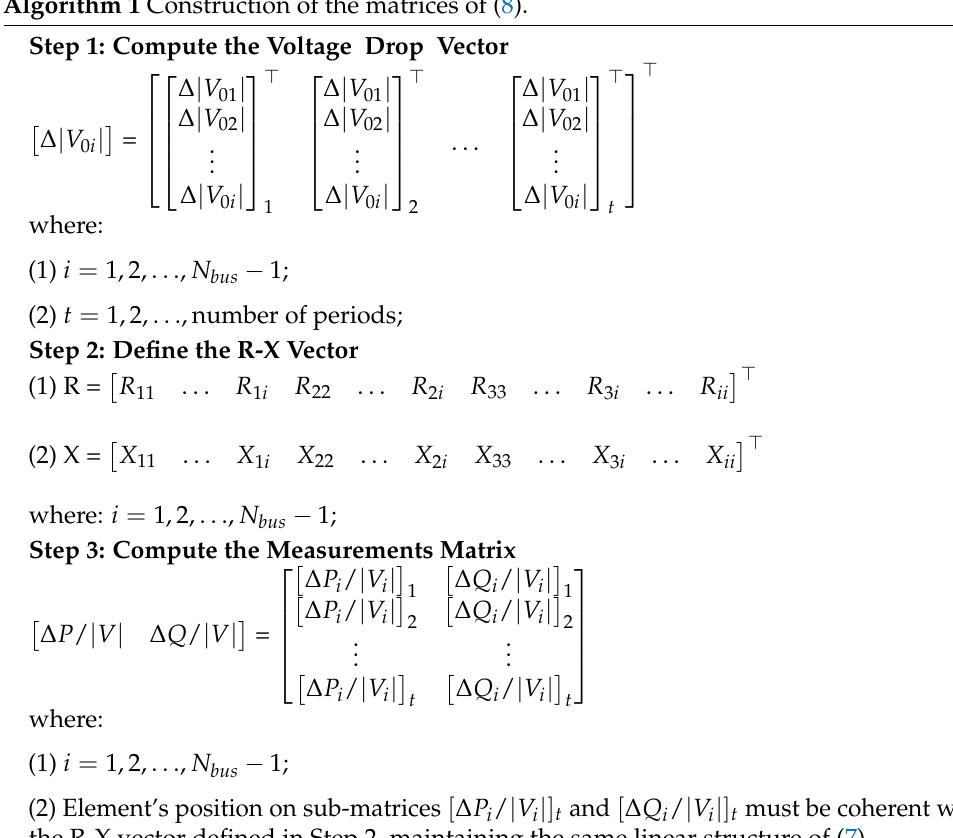
Algorithm 1 Construction of the matrices of